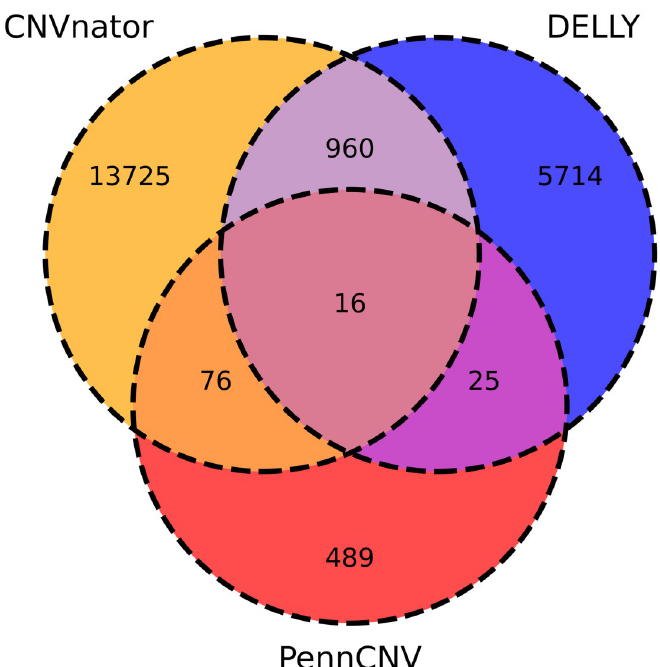
Fig 2. Copy number variation regions identified from whole-genome sequencing data using CNVnator and DELLY software and from SNP panel data using PennCNV software.